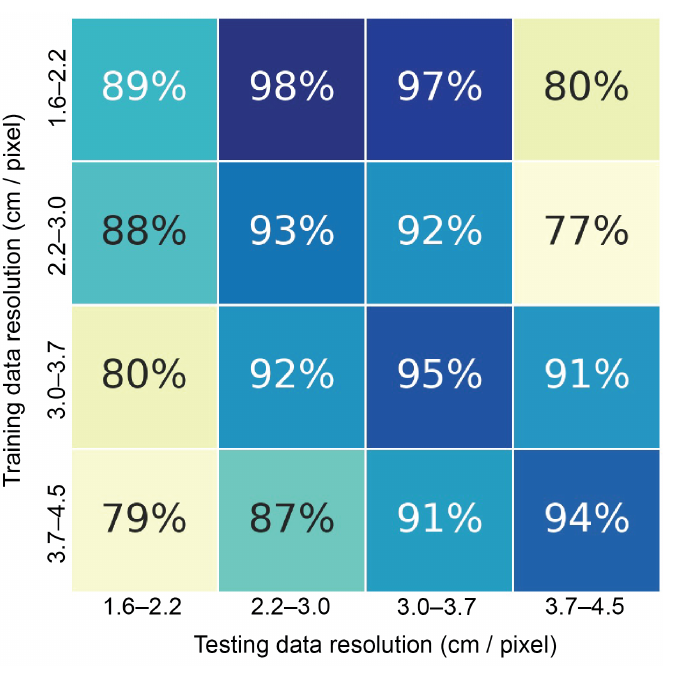
Figure 4. Average Precision score for the training and testing data at various resolutions. The rows are the same training resolution and the columns are the testing resolutions. The bins are grouped so that they correspond to 20 m intervals in flight